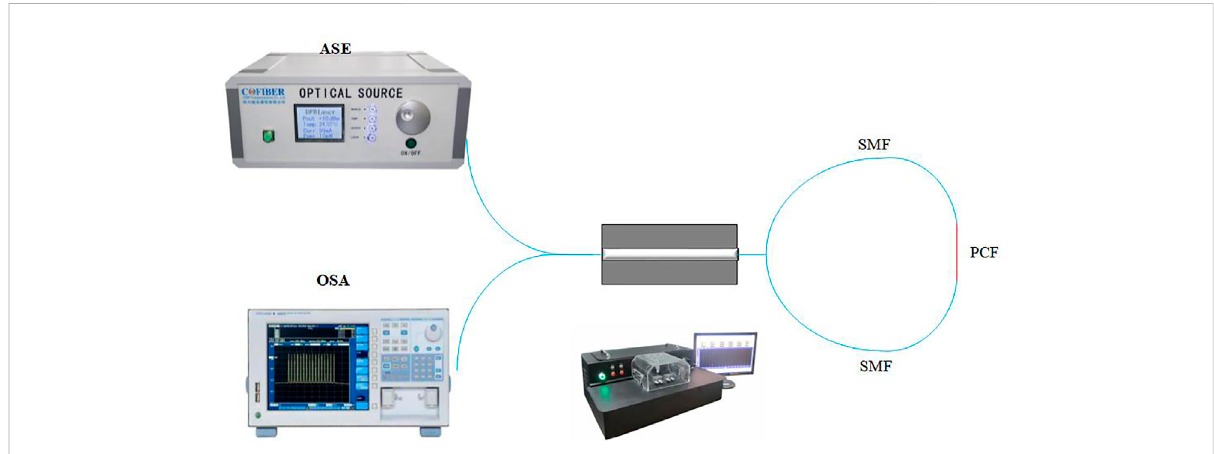
FIGURE 2 Sagnac interferometer sensor structure diagram.